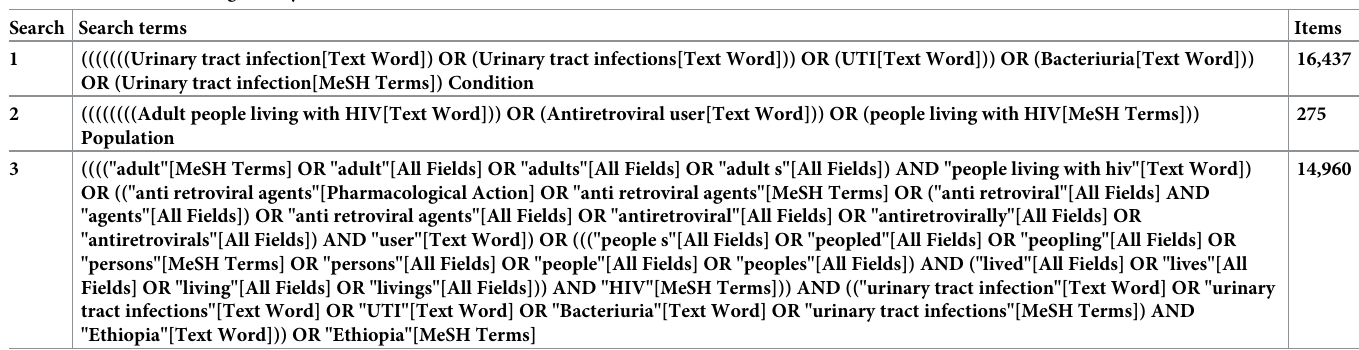
Table 1. Pubmed searching